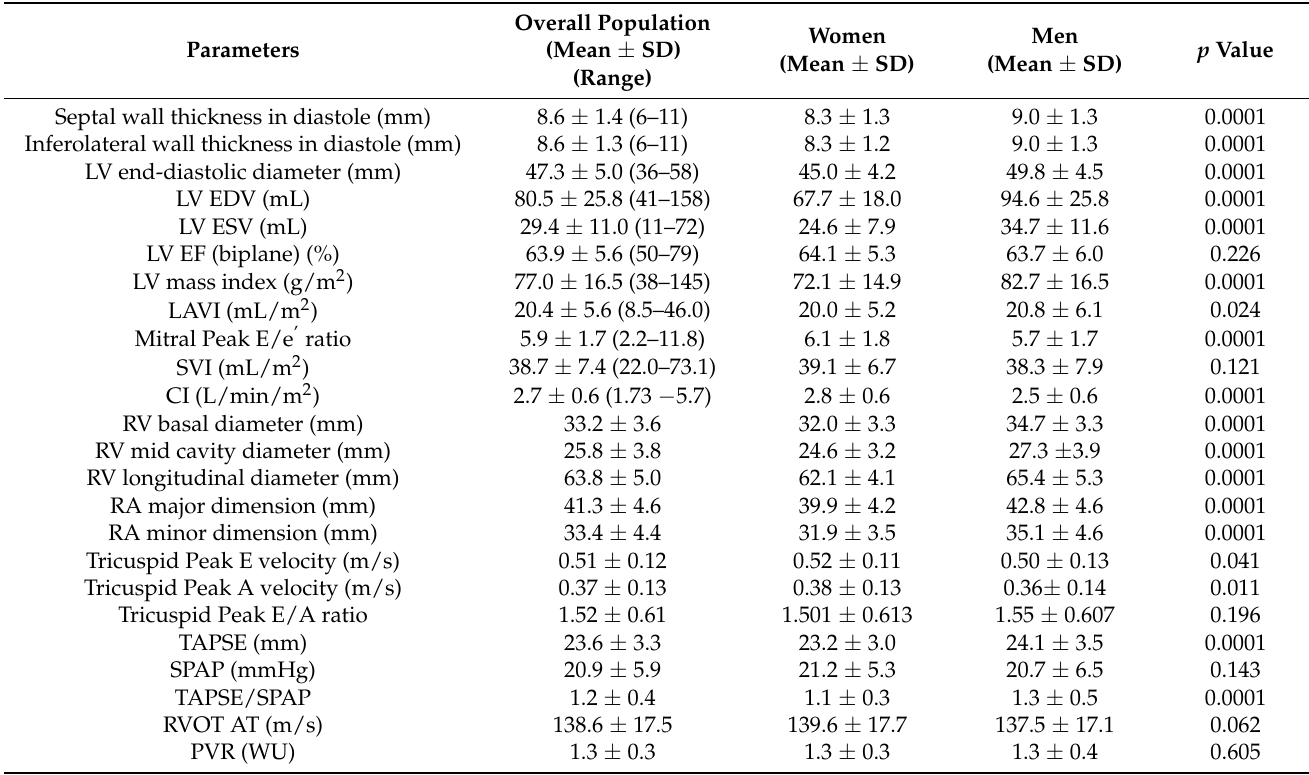
Table 2. Echocardiographic parameters of the study population.